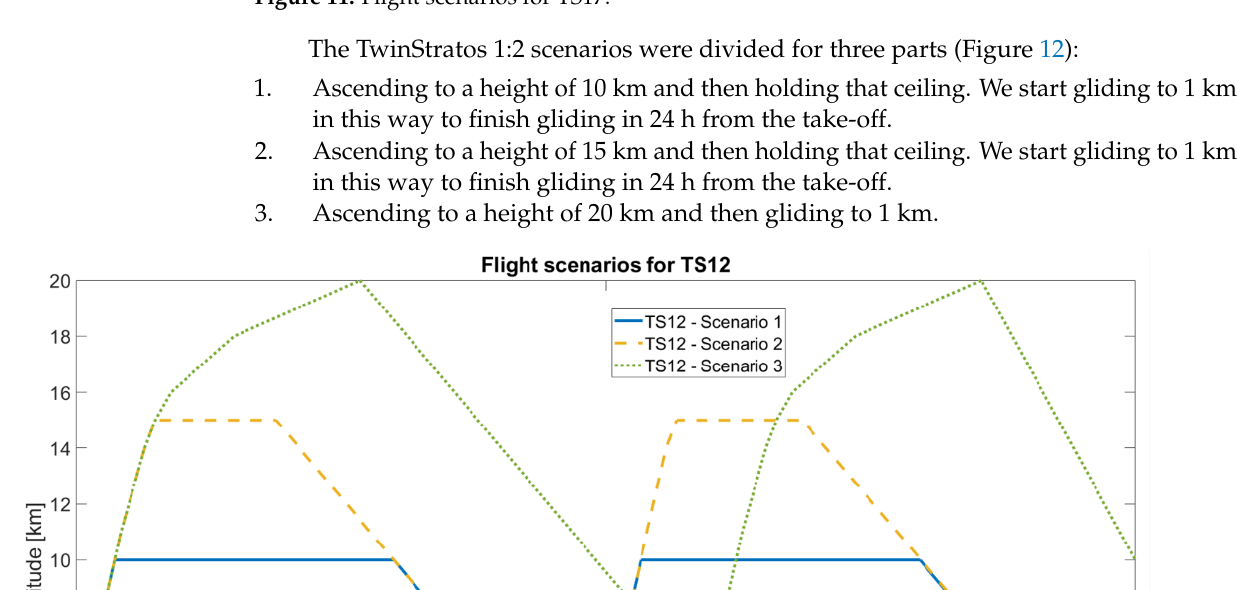
Figure 11. Flight scenarios for TS17.